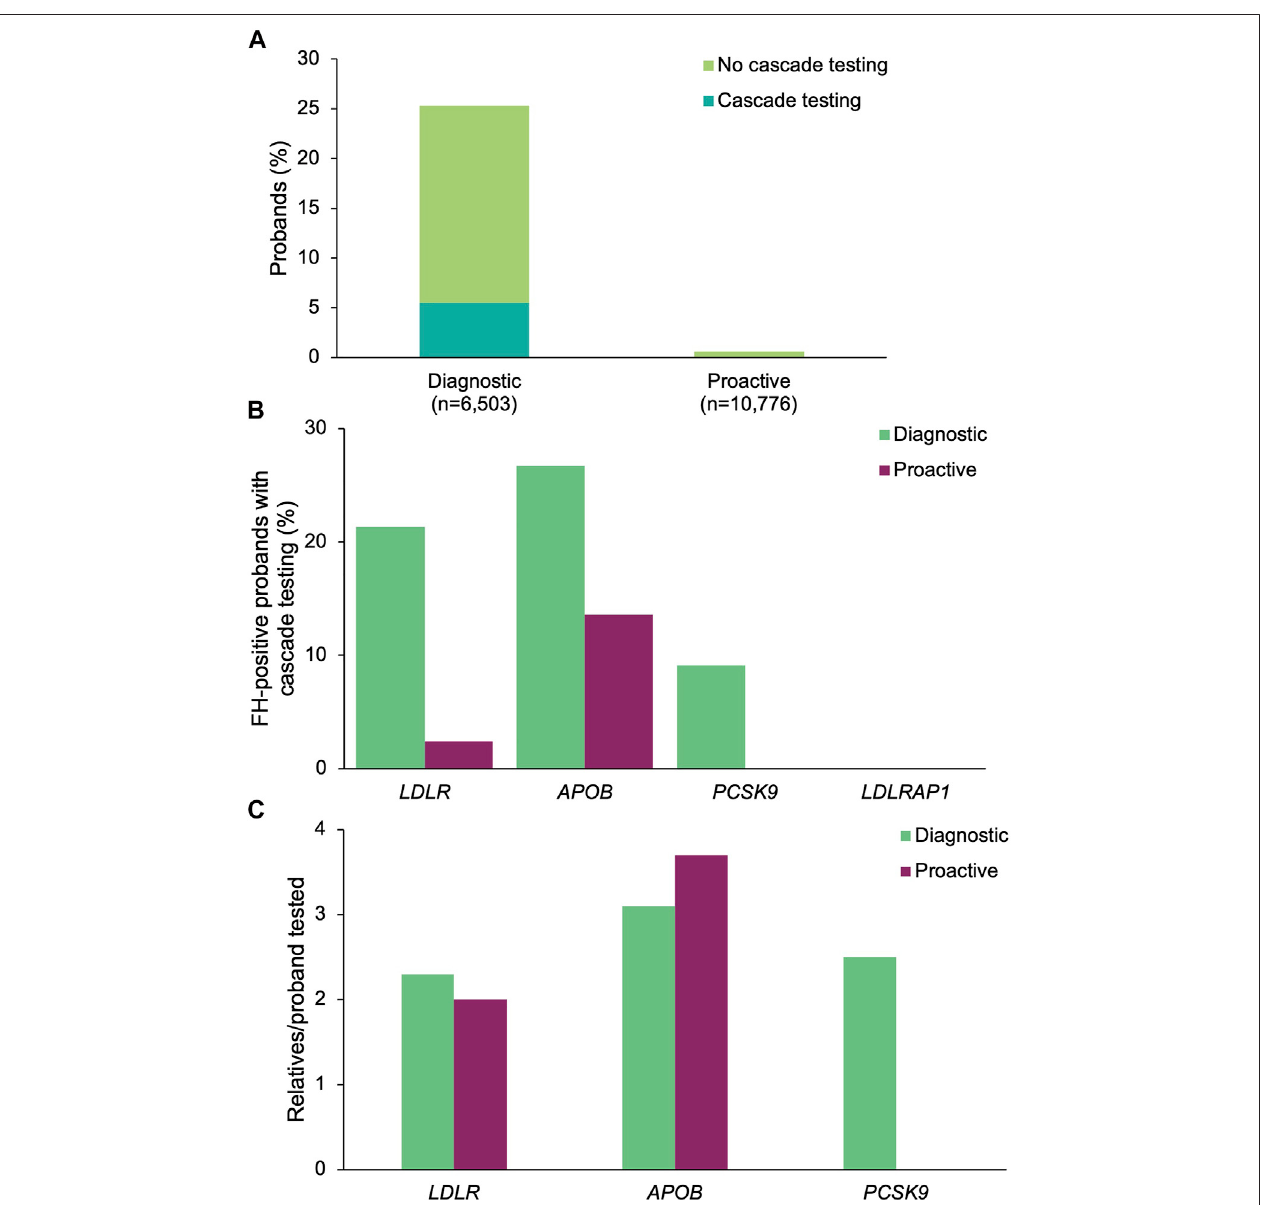
FIGURE4| Yieldofmedicallyactionable(positive) fi ndingsinprobandswhounderwentdiagnostictestingorproactivescreeningforFHgenesandratesofcascade testing. (A) Proportion of diagnostic and proactive probands with a positive result in an FH gene, strati fi ed by whether cascade testing was pursued. The denominator was the total number of probands who underwent diagnostic testing ( n = 6,503) or proactive screening ( n = 10,776) for FH genes. (B) Proportion of probands with a positiveresult ineach FHgene common toboth diagnostic and proactive panels ofinterest who hadat least onerelative pursue cascade testing. Thedenominator was the number of probands with a positive result in each FH gene for each cohort. Probands with a positive fi nding in more than one FH gene were included in calculations for each gene. (C) Mean number of relatives who pursued cascade testing per proband with a positive result in an FH gene. If cascade testing was pursued for positive fi ndings in more than one gene detected in the proband, the relatives and probands were included in the calculations for each gene. FH, familial hypercholesterolemia.